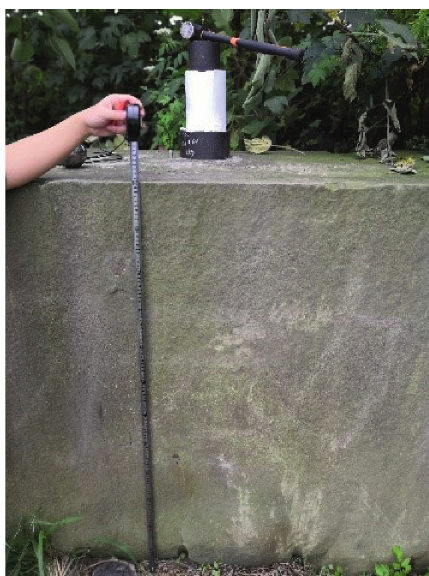
Figure 14: Impact source on 1.2m sandstone.